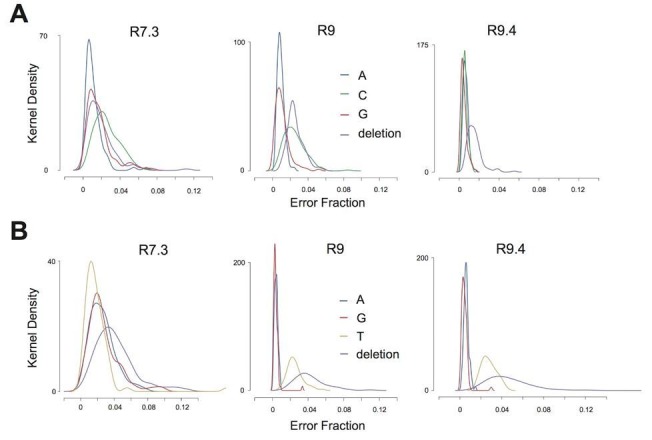
Error rate distribution within K3LHis47Arg sequence context.(A) Kernel density plots representing the distribution of error rates for T>C, T>A, T>G, and T>deletion error across all TATGC 5-mers in data from each flowcell chemistry. (B) Kernel density plots representing the distribution of error rates for C>T, C>A, C>G, and C>deletion errors across all TACGC 5-mers in data from each flowcell chemistry.